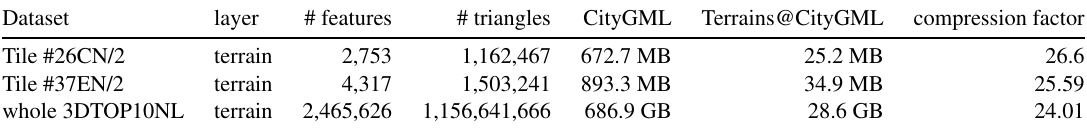
Table 1: CityGML and Terrains@CityGML Outputs